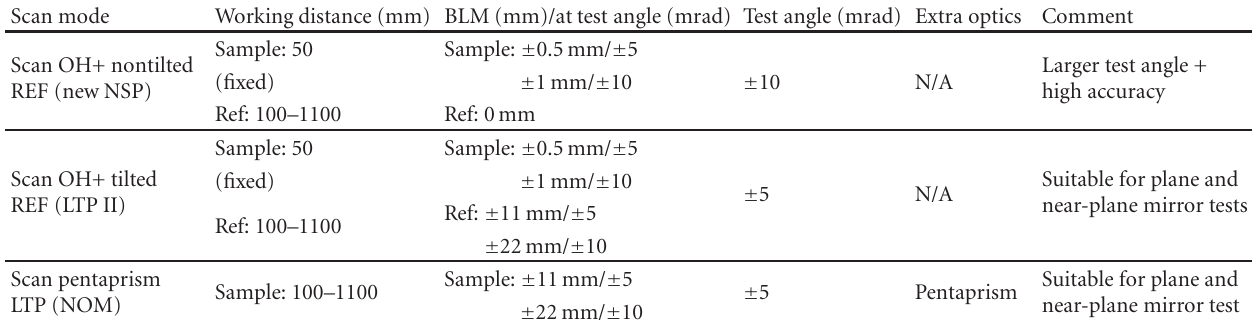
Figure 9: (a) Apply extra angle device to test pitch error; (b) take sample and reference beam tests in sequence; (c) use nontilted reference with tilted sample beam for plane mirror test; (d) employ second optical head; (e) assure non-reference beam by using pentaprism scan for plane mirror test; (f) alternatively switching on/o ff of sample and reference beams. Table 2: Comparison of three scan